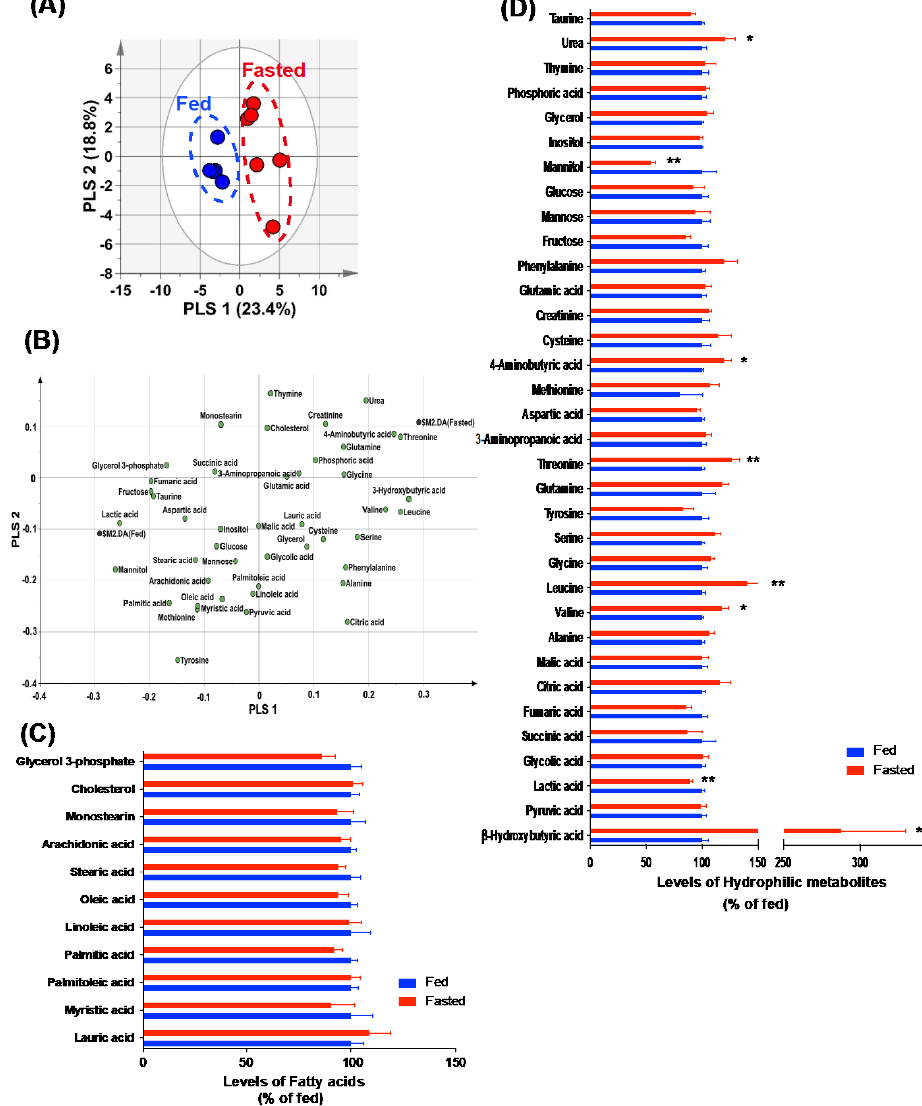
Figure 2. Metabolic profiling of the hypothalami of fasted mice. Hypothalamic metabolites were analyzed in the control and fasted mice using GC − MS. ( A ) Score and ( B ) loading plots of the PLS − DA model were obtained from 45 metabolites. ( C ) No difference in the levels of hypothalamic fatty acids was observed between the fasted and control mice. ( D ) A normalized graph showing altered hydrophilic metabolites in the hypothalami of fasted mice, compared to those in control